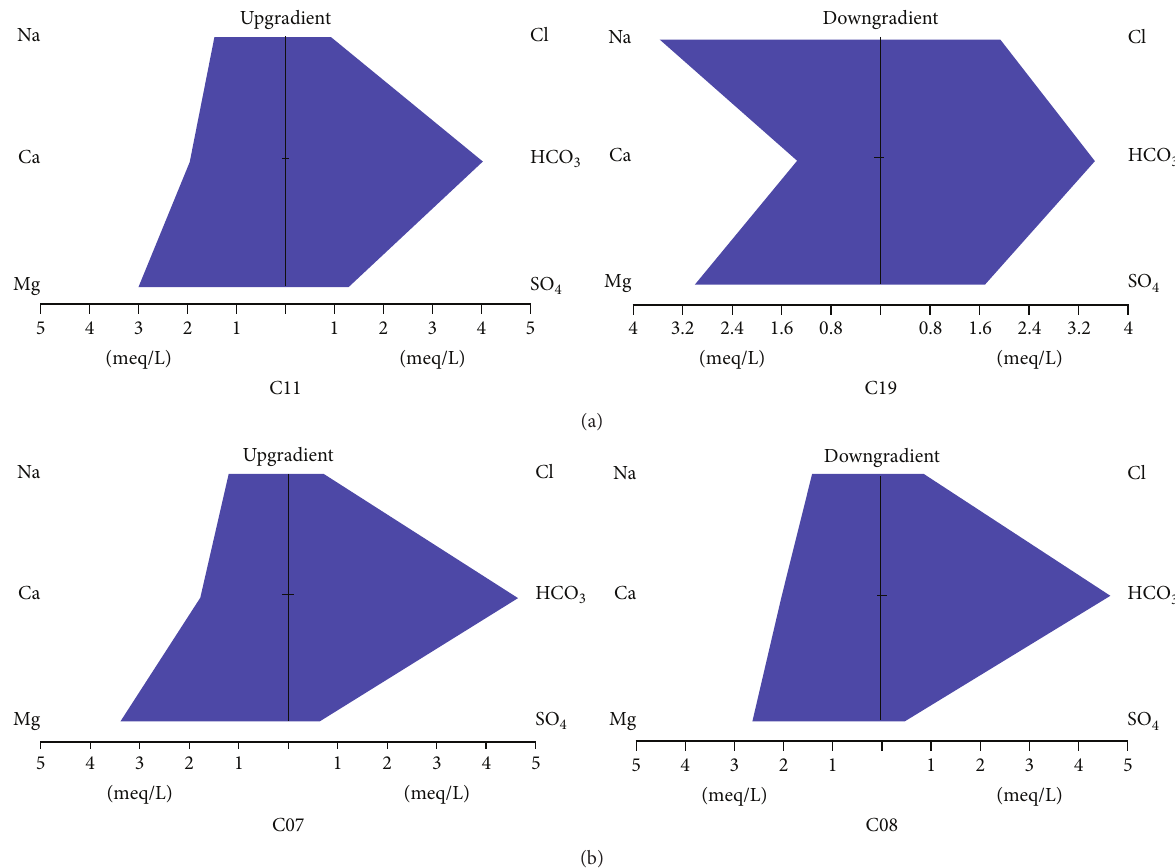
Figure 7: Major ion variations along flow paths: (a) from C11 to C19; (b) from C07 to